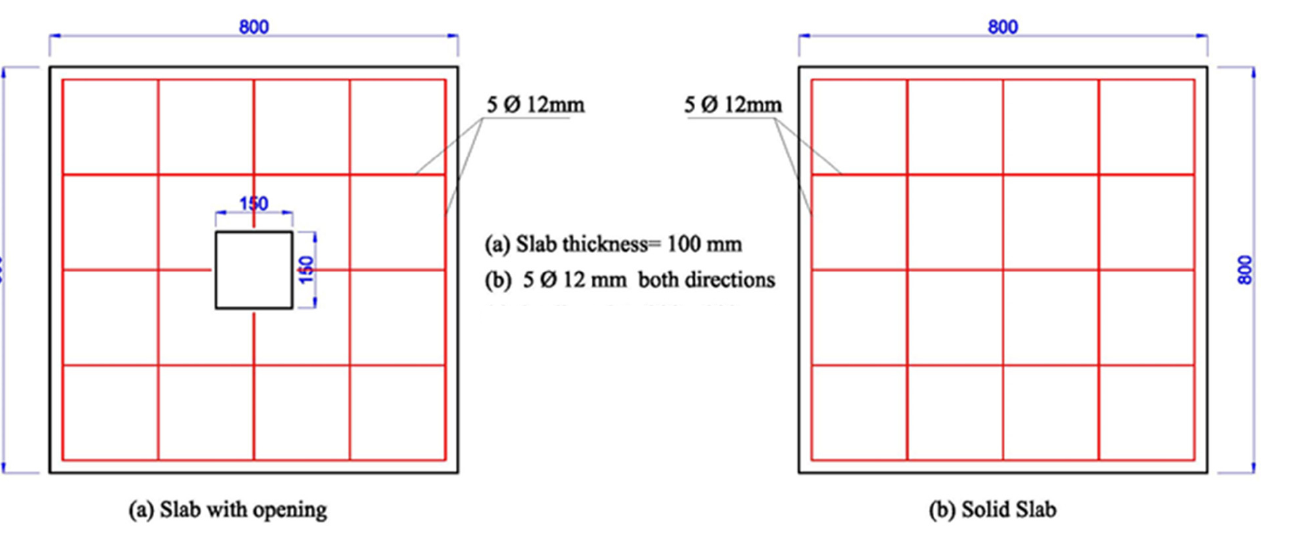
Figure 3. Two-way reinforced slab details (mm) as: ( a ) slab with opening; ( b ) solid slab.